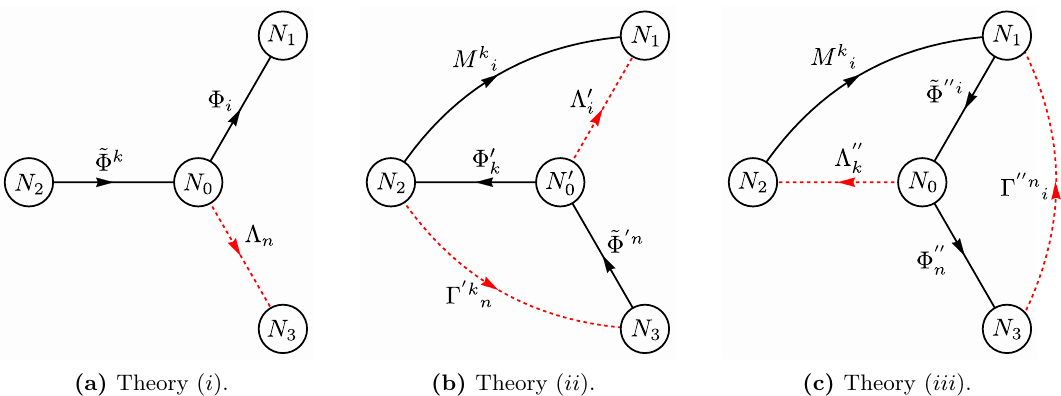
Figure 6 . Triality as a local operation at a quiver node. The transformation of the interaction terms under triality is discussed in the main